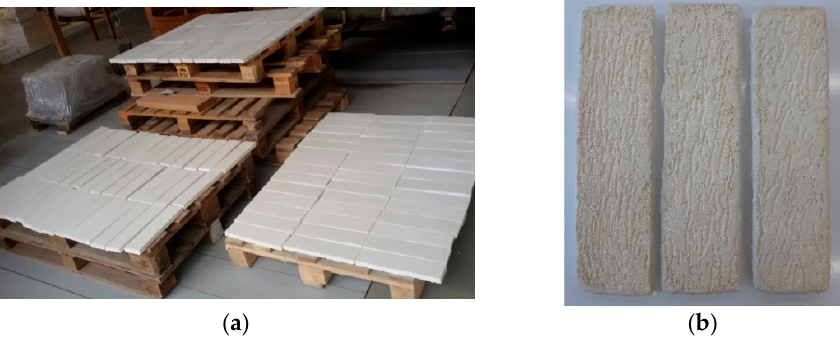
Figure 3. Plaster samples for laboratory tests: ( a ) sample conditioning method; ( b ) shape and sample texture (filled